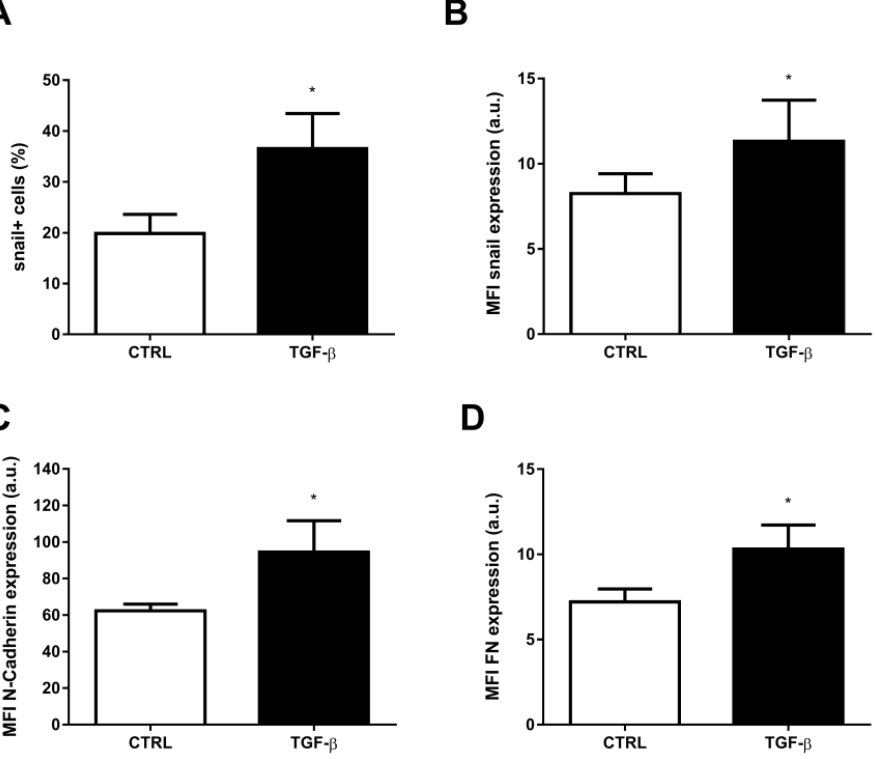
Figure 2. TGF- β increases expression of proteins related to epithelial-mesenchymal transition (EMT). A549 cells (1 × 10 5 cells/mL) were incubated with 5 ng/mL TGF- β for EMT induction. After 48 h, the cells were stained with antibodies against ( A , B ) snail, ( C ) N-cadherin and ( D ) fibronectin (FN) and ( A ) percentage of positive cells and ( B – D ) protein expression were evaluated by flow cytometry. Ex- pression is represented by median fluorescence intensities (MFI). Bars represent mean + SEM, and the values of significance were represented by (*) for p < 0.05 from at least four independent